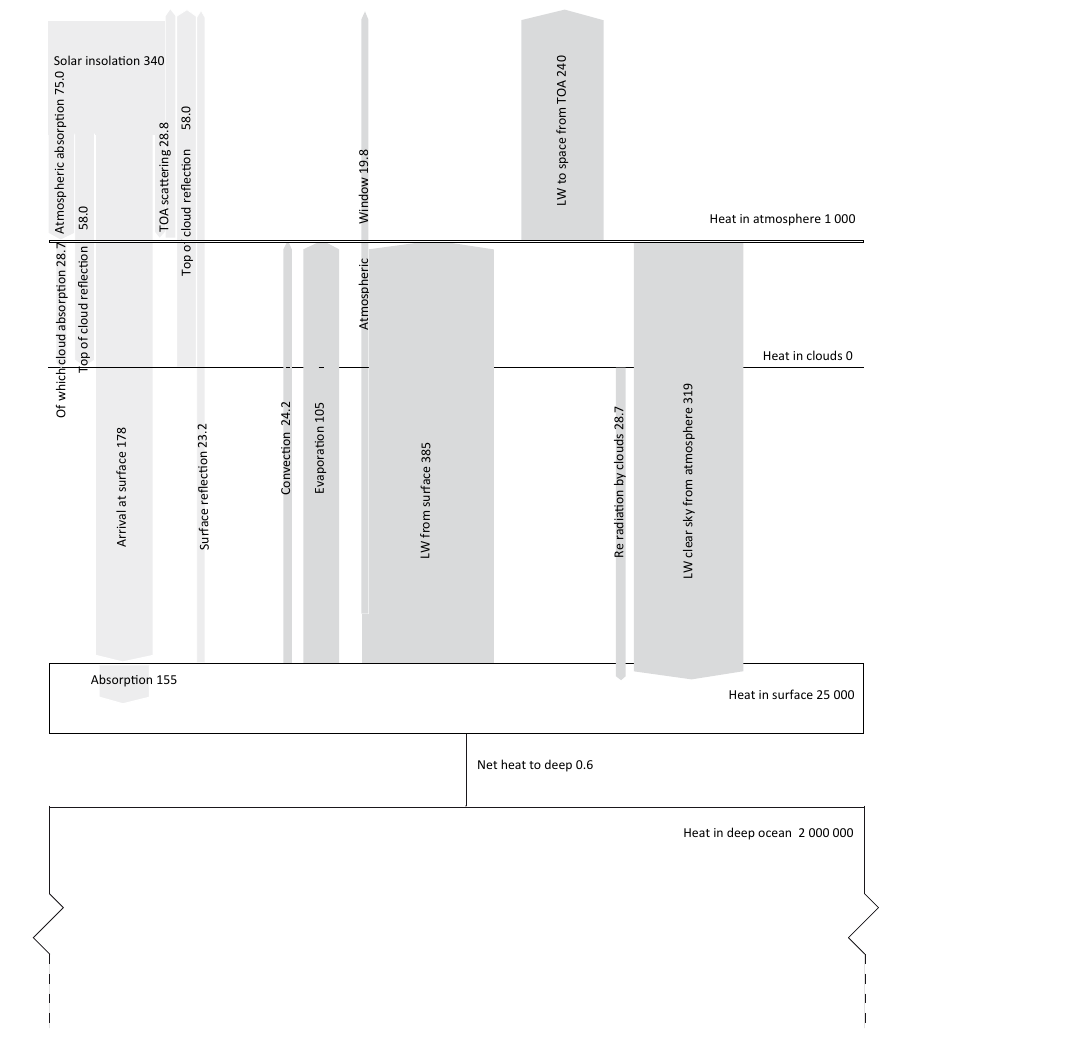
Figure 4. Stocks (in ZJ) and flows (in Wm − 2 ≈ 16ZJyr − 1 for whole Earth) in the energy sector of ESCIMO. World around the year